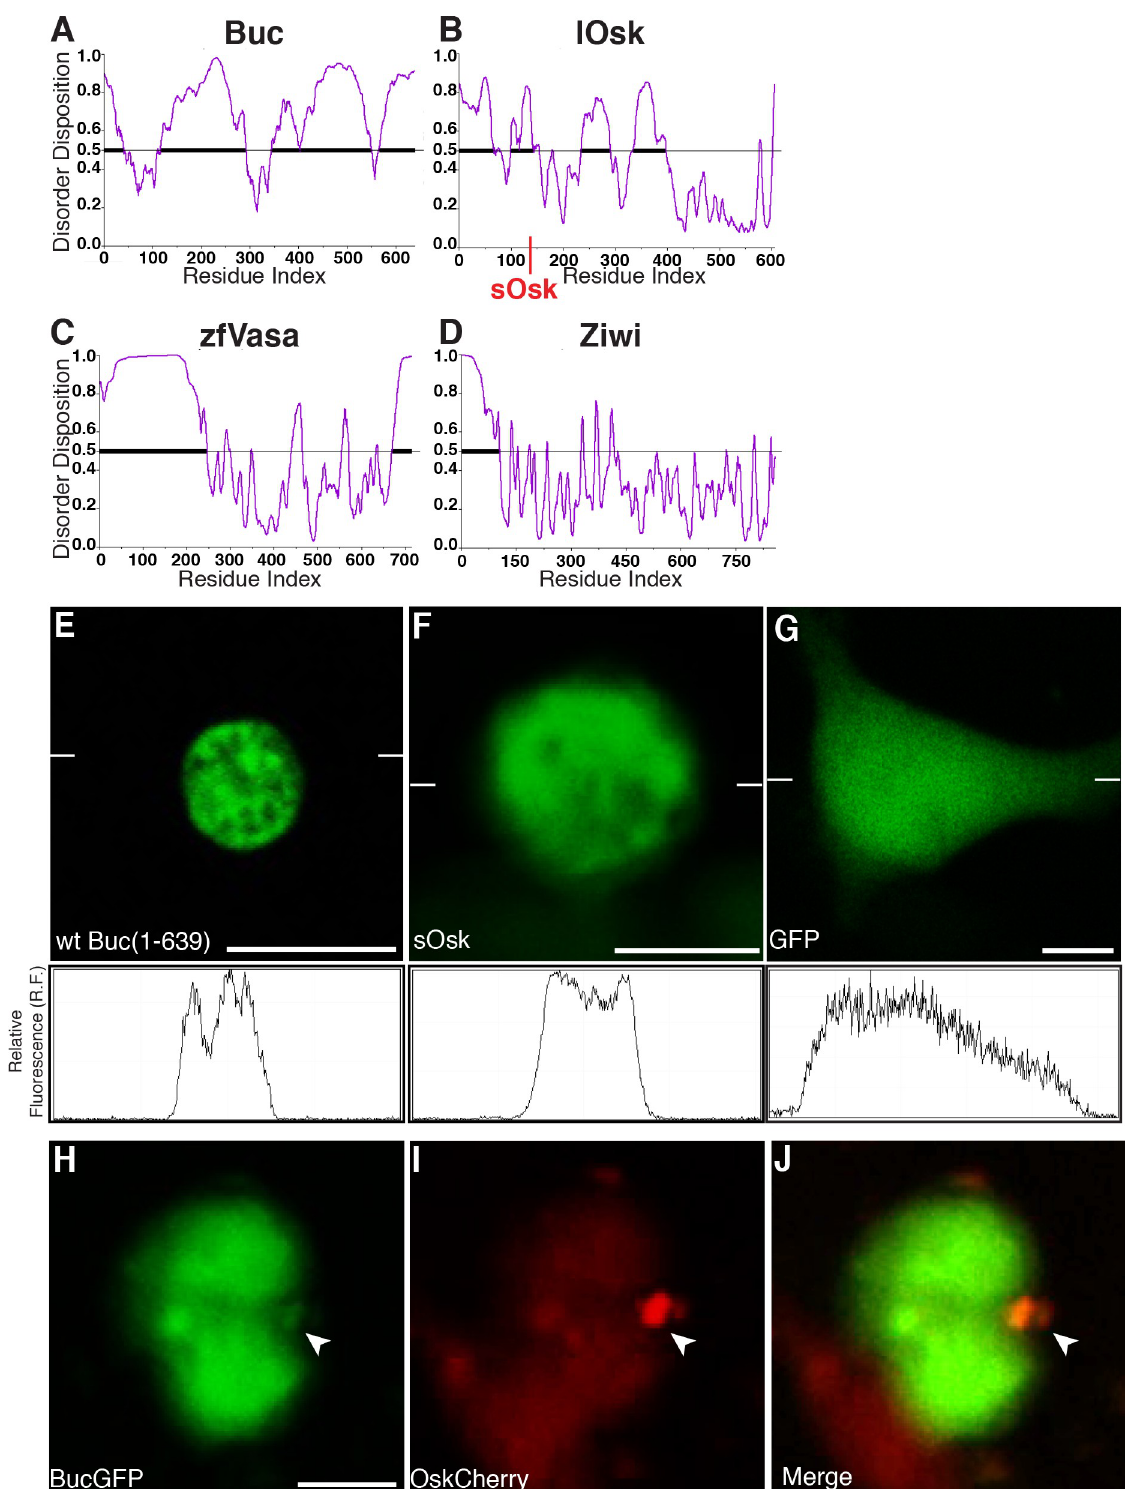
Fig 4. Buc and Osk contain intrinsically disordered regions. Predicted protein disorder in (A) Buc, (B) Osk, (C), Vasa, and (D) Ziwi. Disorder disposition (y-axis) plotted against the amino acid residue index (x-axis). Values above the 0.5 threshold (grey bar) show the propensity for disordered regions (bold line). The red line at aa 139 in Osk indicates the alternative translation initiation site for short